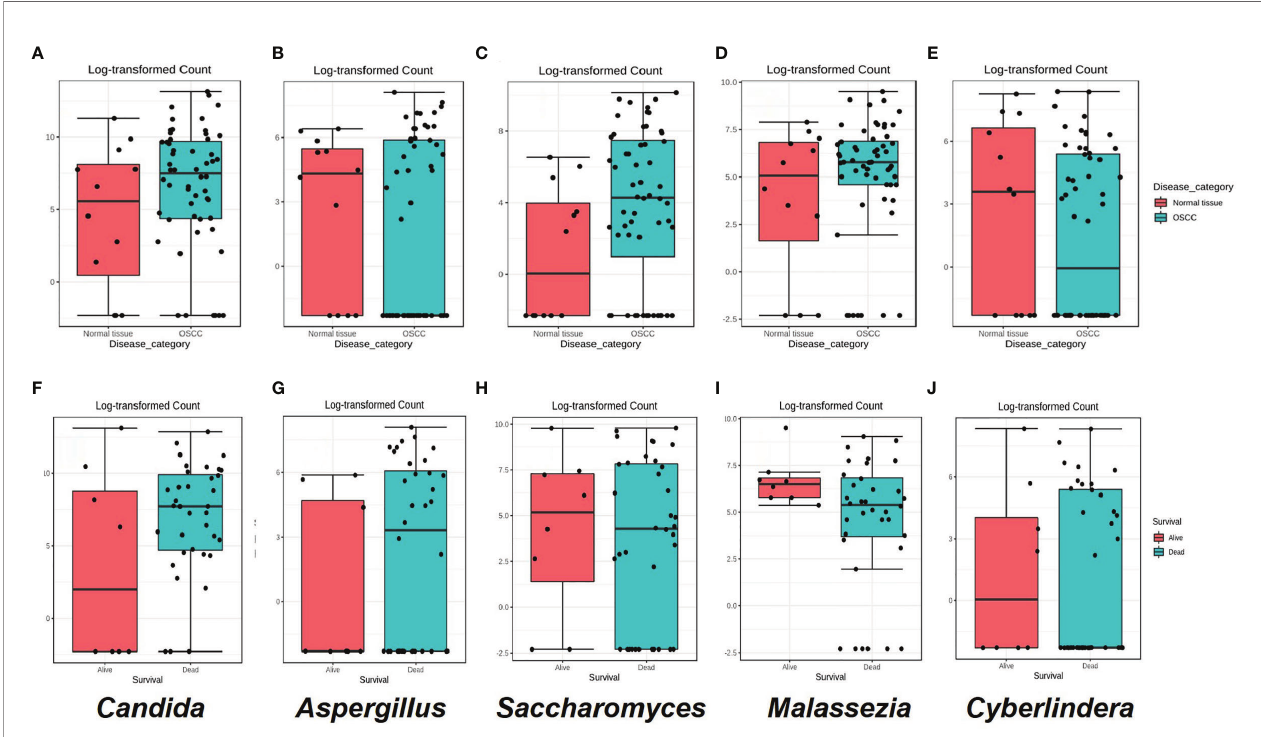
FIGURE 4 | (A – E) Box plots for the abundance of the top fi ve genera in the the oral squamous cell carcinoma (OSCC) group versus non-OSCC controls. (F – J) Box plots for the relative abundance of the top fi ve genera in OSCC patients who were dead or alive at the end of the study period. Classical univariate statistical comparison of the relative abundance showed no statistically signi fi cant